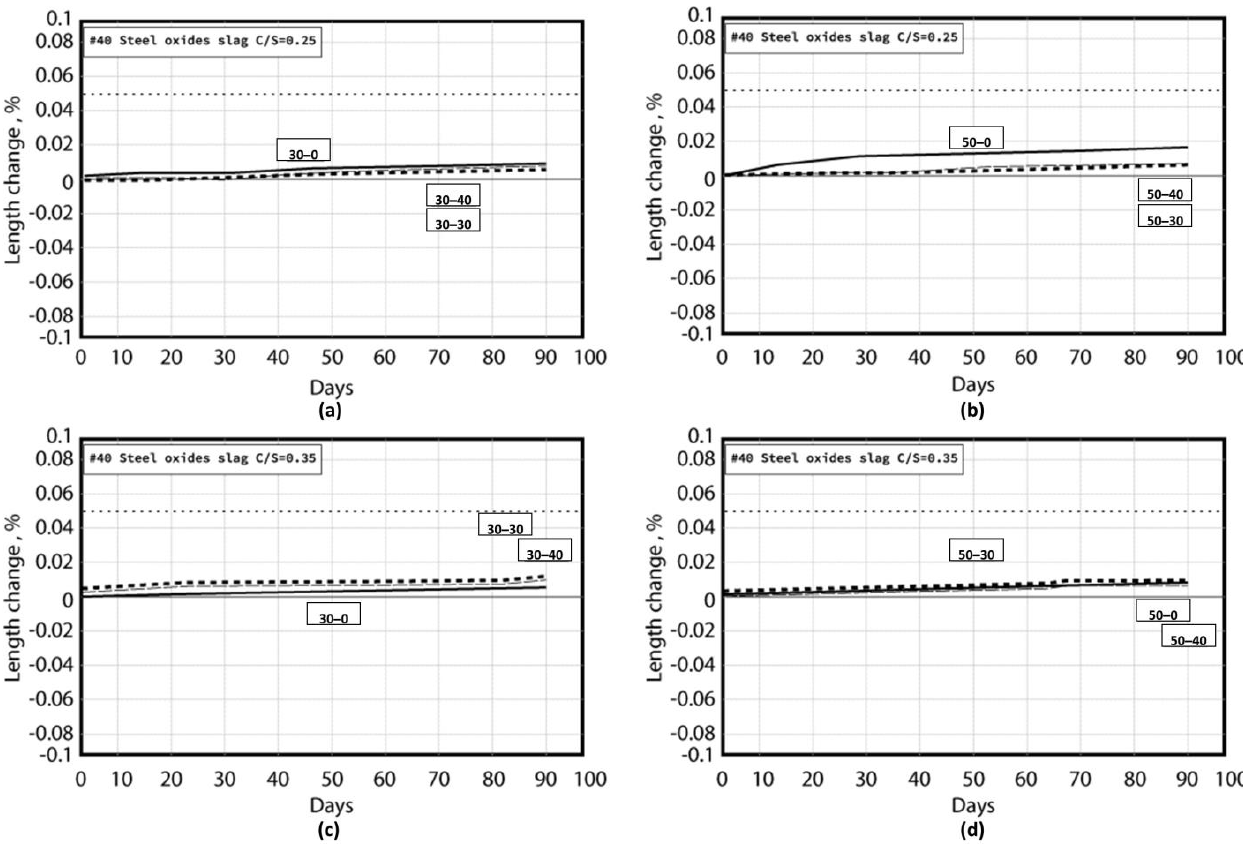
Figure 6. Compressive combination strengths on the 0.25 ratio. ( a ) EAF oxidizing slag adjunction with a percentage of 50%. ( b ) EAF oxidizing slag adjunction with a percentage of 30%.